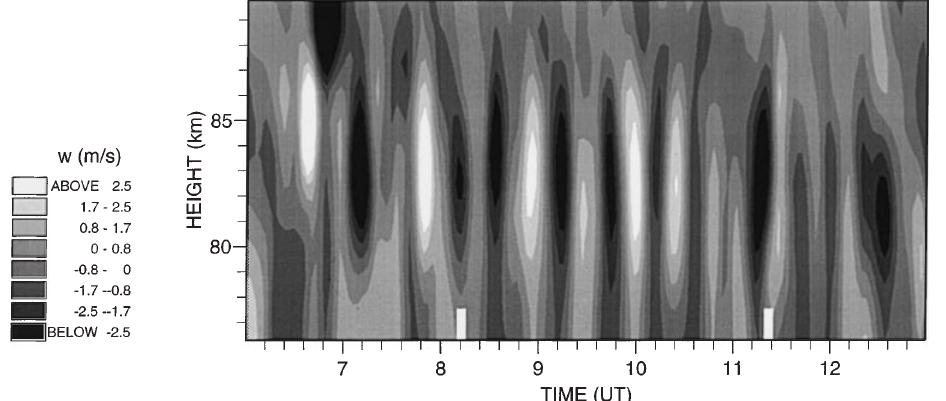
Fig. 2. Time-height contours of vertical velocity for data recorded on 31 July, 1992 between 06:00– 13:00 UT at heights of